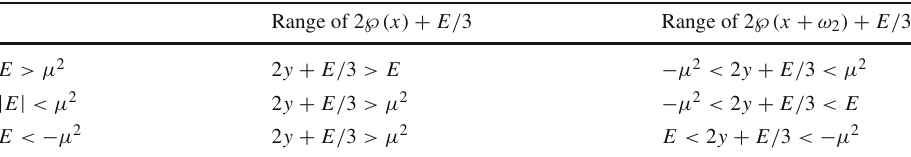
Fig. 2 The translationally invariant elliptic solutions of the sine-Gordon Eq. (3.16), for various values of the energy constant